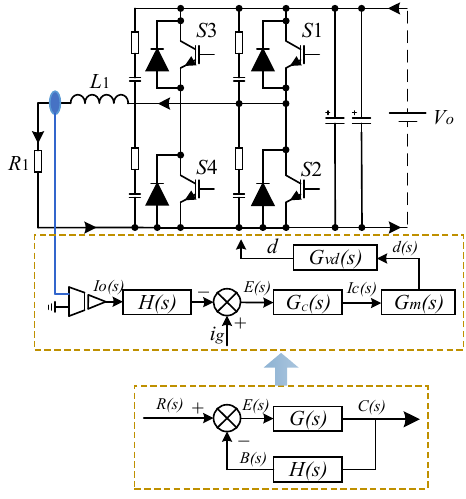
Figure 10. Small-signal block diagram of the converter.